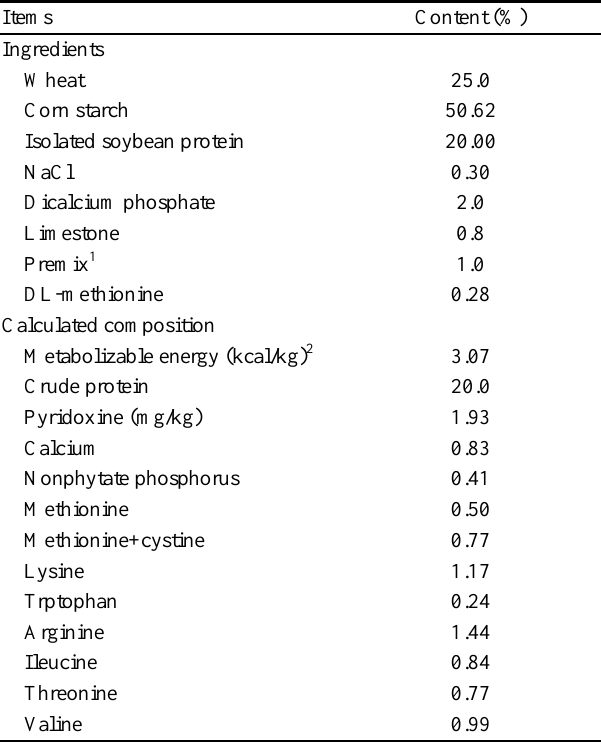
Table 1. Composition of basal diet (% as fed)